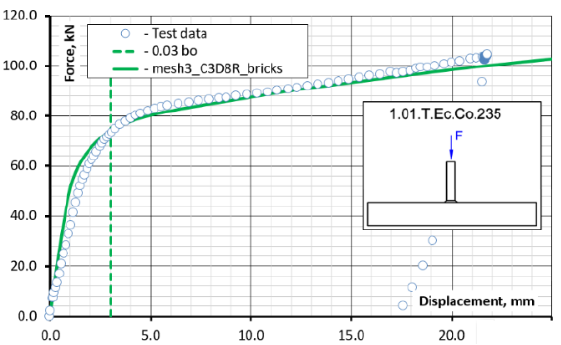
Figure 7. Validation of FE models against labora- tory tests for an o ff set